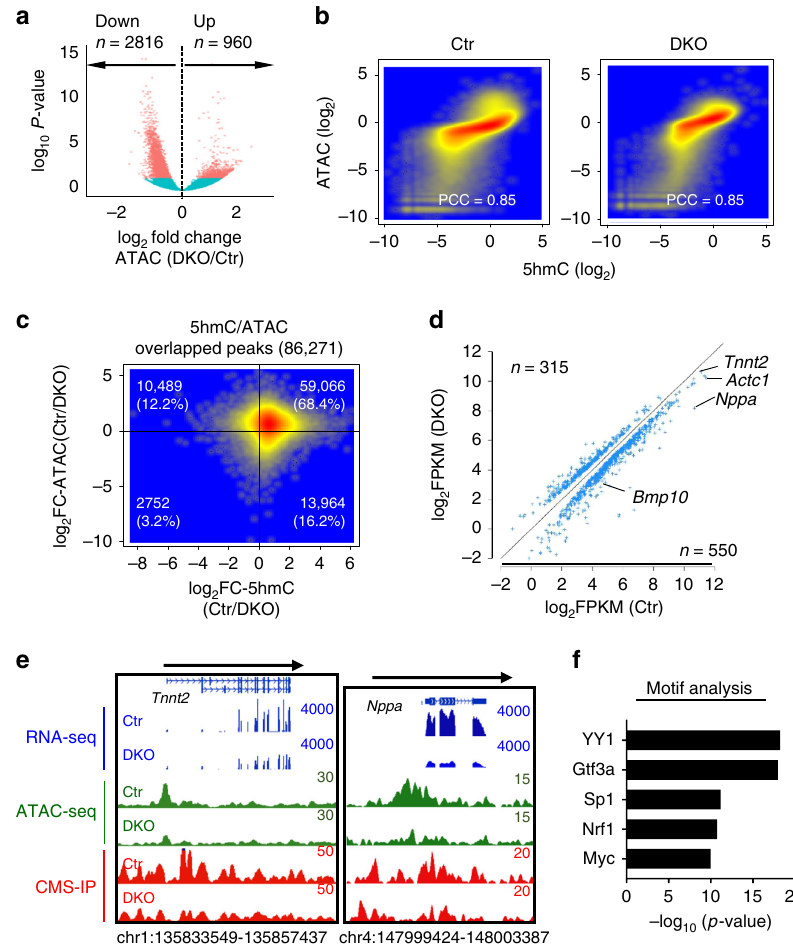
Fig. 5 Tet2/3 deletion in murine embryonic hearts reduced chromatin accessibility. a Volcano plot depicting the differential ATAC-seq enriched regions between the control and Tet2/3-DKO groups ( p value < = 0.05). Data were collected from E12.5 embryonic heart tissues obtained from control and Tet2/ 3-DKO mice. b Scatterplot depicting the correlation between 5hmC and ATAC-seq signals in the control (left) and Tet2/3-DKO (right) groups. Pearson correlation coef fi cient was calculated by correlating 5hmC signals with ATAC-seq signals obtained from E12.5 cardiac tissues. The ATAC and 5hmC signals of every 10 kb bin were calculated. c Scatterplot depicting the distribution of genomic regions with altered 5hmC ( x -axis) and ATAC-Seq signals ( y -axis) between the control and Tet2/3-DKO groups. Normalized 5hmC and ATAC signals were used in the plot. d Scatterplot presenting the expression of DEGs that showed decreased in 5hmC and ATAC-seq signals within 2 kb of transcription start sites (TSS). Tnnt2 , Actc1 , Nppa , and Bmp10 were among the hits. e Genome browser view examples of decreased transcription (blue, RNA-seq), chromatin accessibility (green, ATAC-seq) and 5hmC (red, CMS-IP) enrichment at cardiac-speci fi c gene loci ( Tnnt2 and Nppa ) in Tet2/3-DKO E12.5 heart tissues compared with that in control group. f Motif enrichment analysis on genomic regions displaying decreased ATAC-seq signals in the Tet2/3-DKO group. Benjamini – Hochberg corrected hypergeometric p -value were